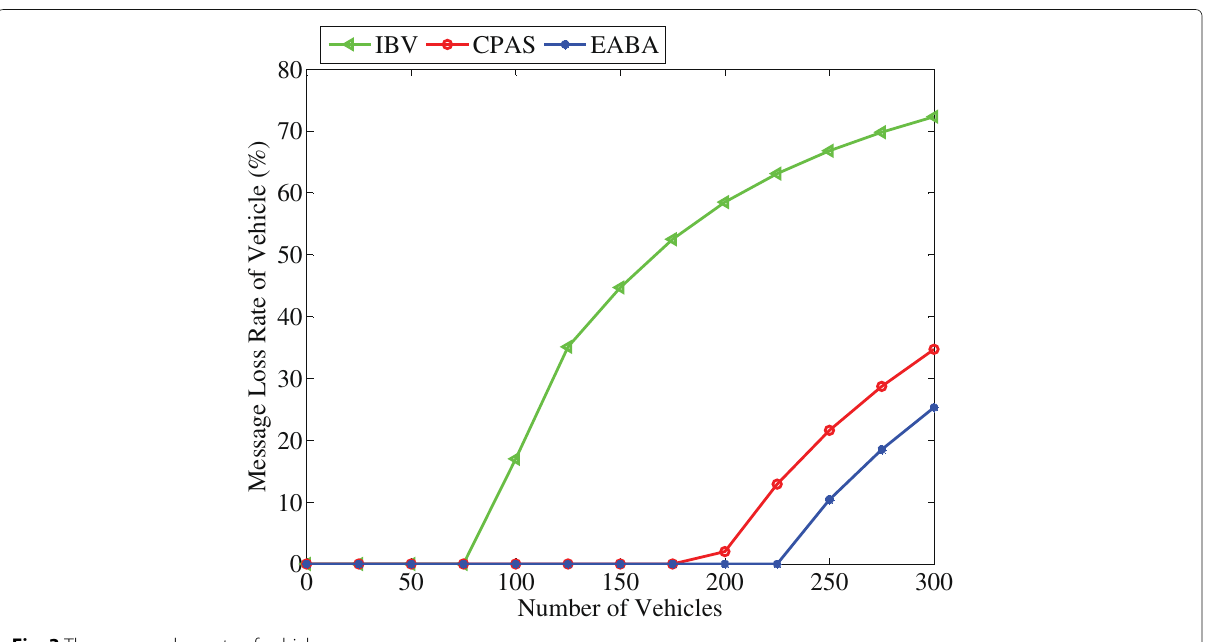
Fig. 3 The message loss rate of